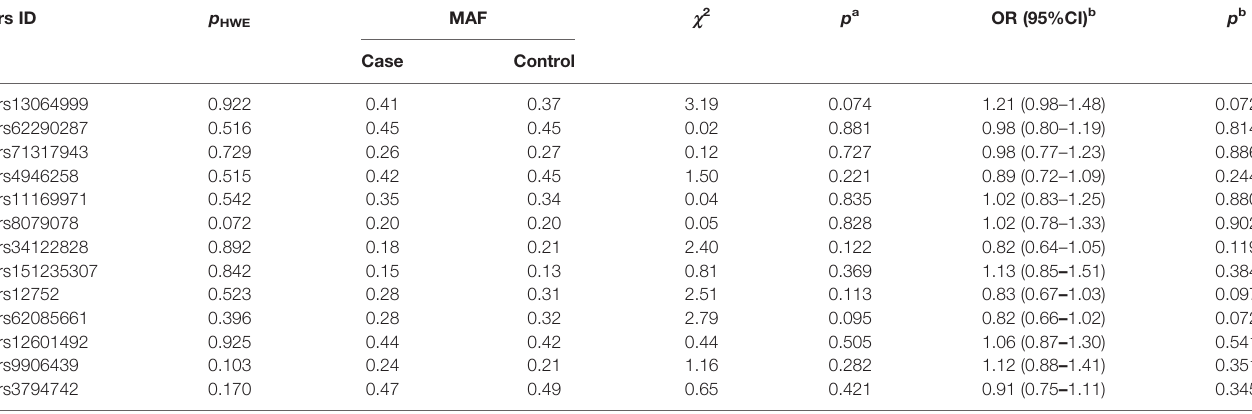
TABLE 2 | Results of association analyses between individual SNPs and NSCLC risk in stage 1. rs ID